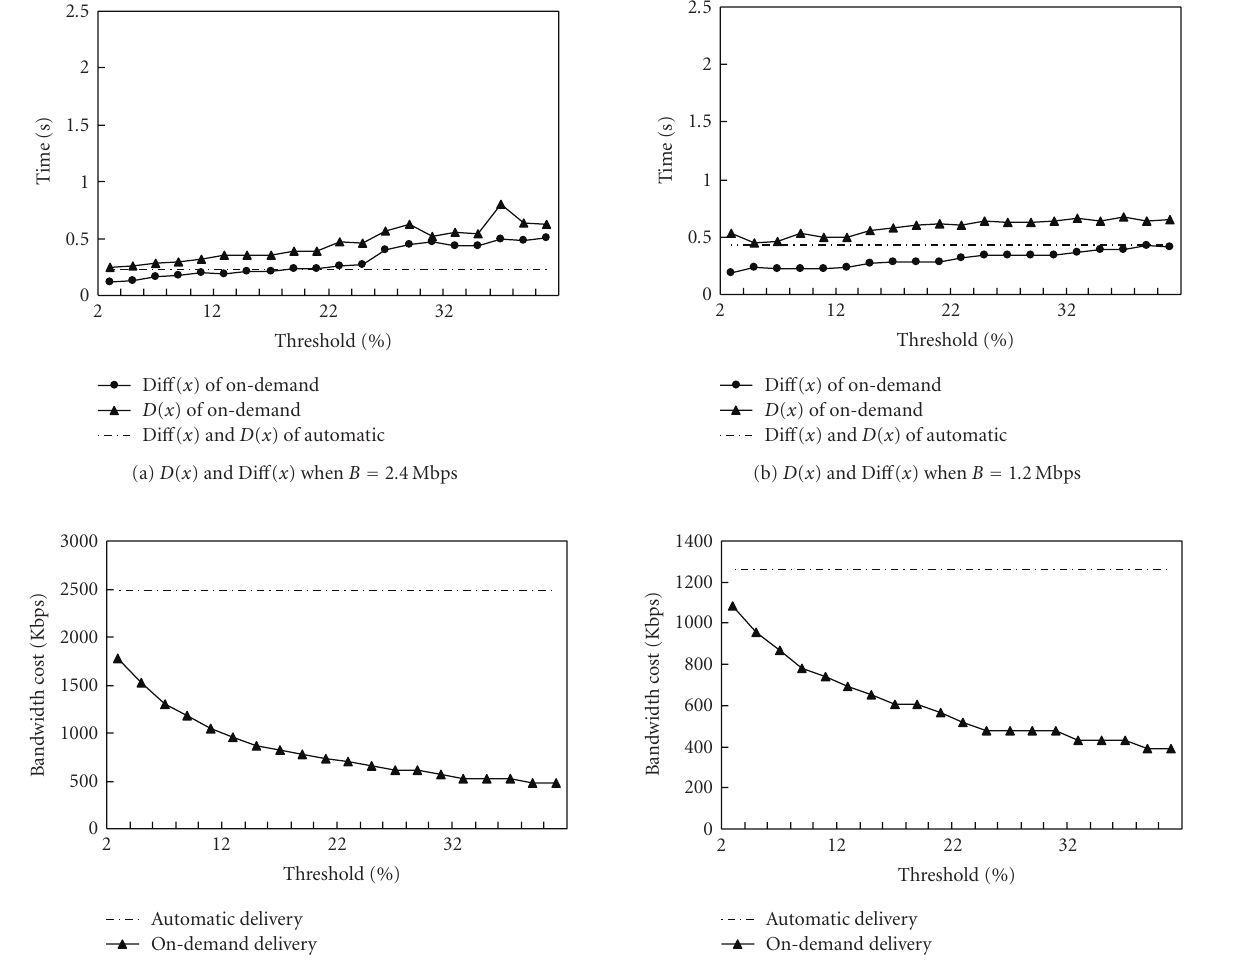
Figure 8: Average latency and di ff erence of a gymnastics